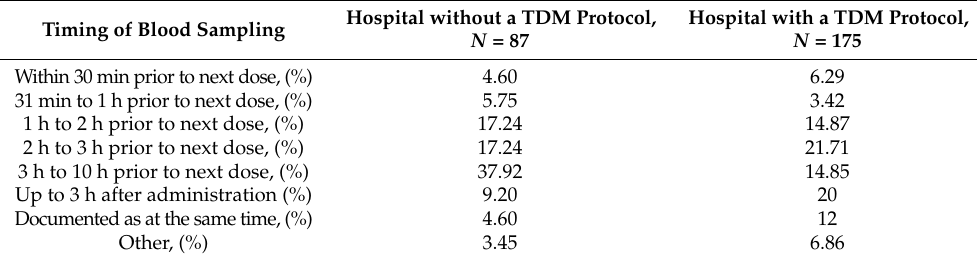
Hospital without a TDM Protocol, Hospital with a TDM Protocol, N = 87 N = 175